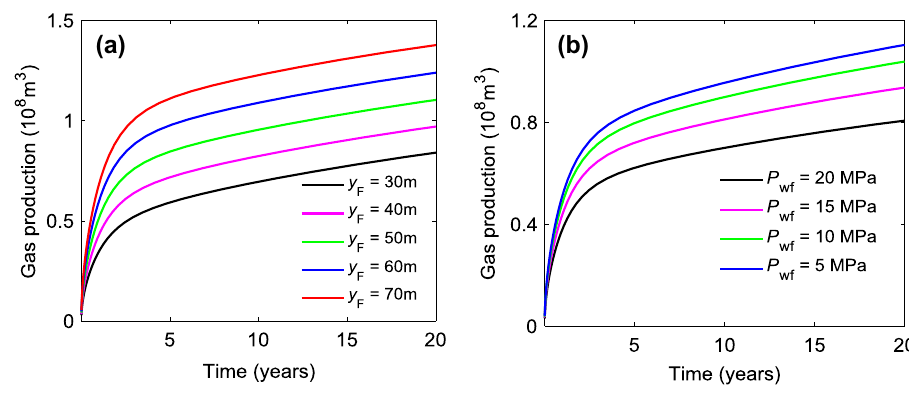
Fig. 3 Gas production for differ-